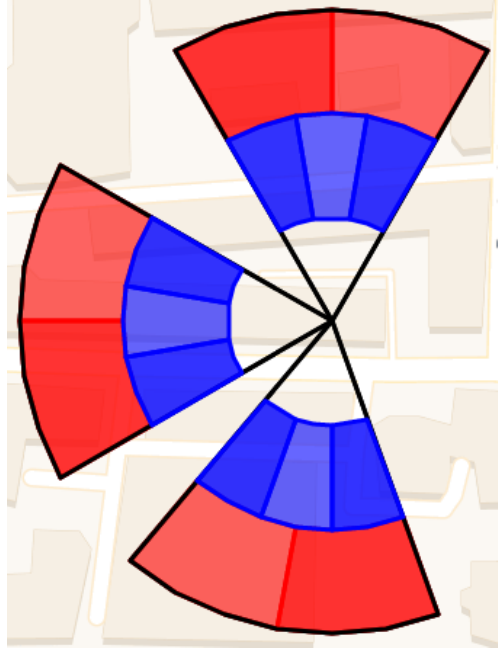
Figure 7. Novel visual representation of cells in a site.